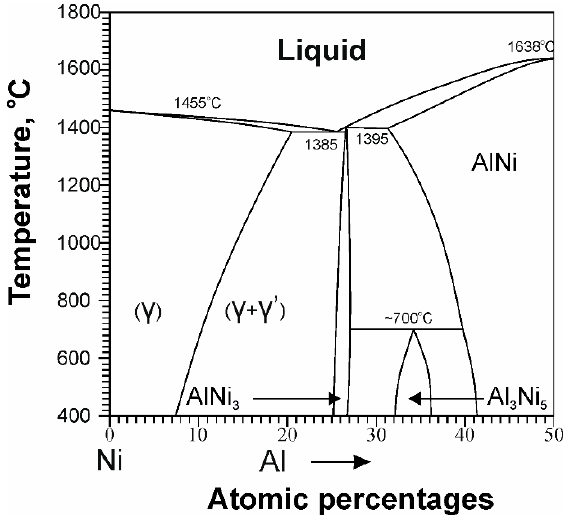
Figure 1. Schematic binary Ni ‐ Al phase diagram. Taken from Ref. [12] with permission from ASM. Copyright 1986, ASM.